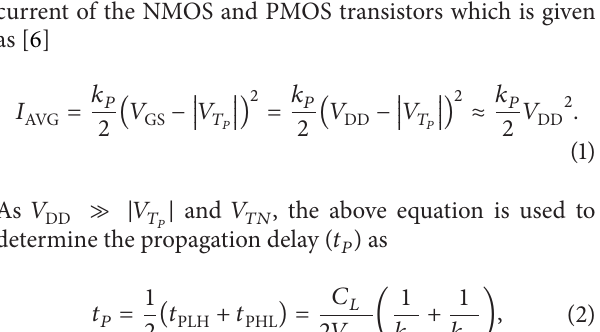
current of the NMOS and PMOS transistors which is given as